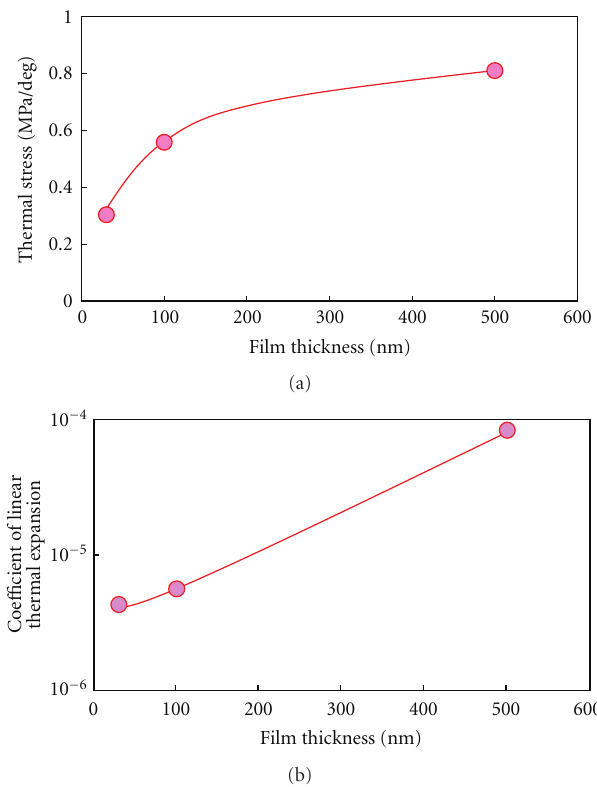
Figure 11: Thermal stress and coe ffi cient of linear thermal expan- sion of GZO films formed by the RPD system as a function of film thickness. (a) Dependence of thermal stress on film thickness, and (b) dependence of the coe ffi cient of linear thermal expansion on film